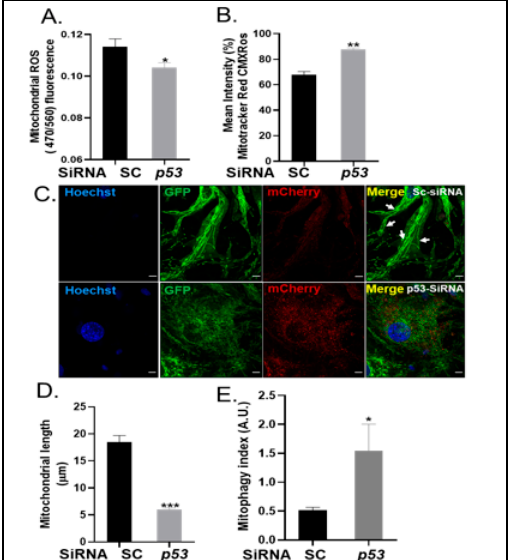
Figure 6. Knockdown of p53 in calcified VSMCs reduces mitochondrial length and improves mitochondrial function. VSMCs were transfected with either scrambled (SC) or p53 siRNA and cultured with high phosphate (3mM Pi) for up to 14 days. Quantification of ( A ) mitochondrial reactive oxygen species (ROS) (470/560 nm) and ( B ) mitochondrial membrane potential by mitotracker red CMXRos (mean intensity). ( C ) Representative confocal images of mito-QC VSMCs (white arrows show hyperfused mitochondria). Quantification of ( D ) mitochondrial length (µM) and ( E ) mitophagy index. Data shown as mean +/ − S.E.M. (n = 3–6) * p < 0.05; ** p < 0.01; *** p < 0.001 compared to control. Scale bars = 10 µm.